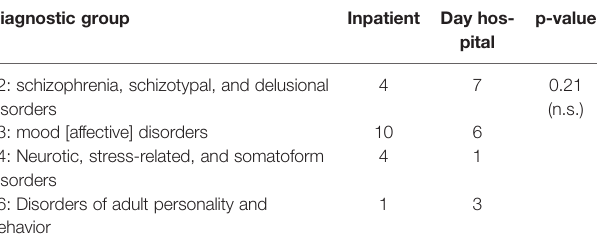
TABLE 3 | Distribution of the psychiatric treatment diagnoses, itemized according to the diagnostic groups of the International Classi fi cation of Diseases (ICD-10), global p-value (Chi-square-test, inpatient versus day hospital).